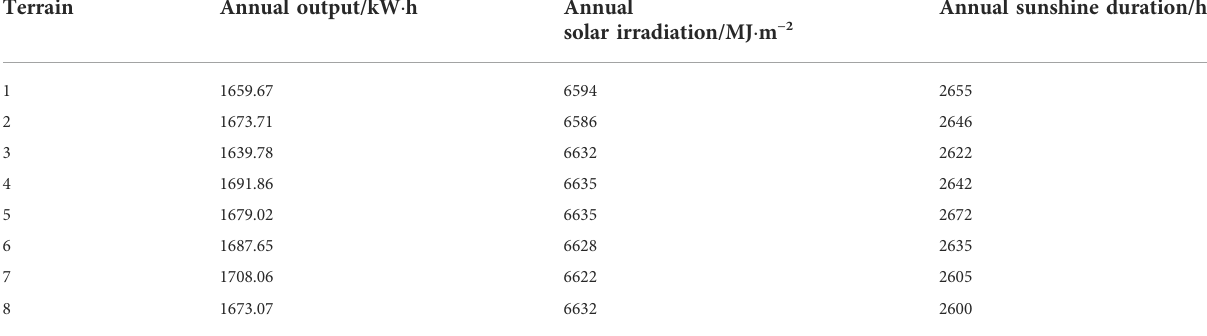
TABLE 4 The PV resource parameters of each terrain.